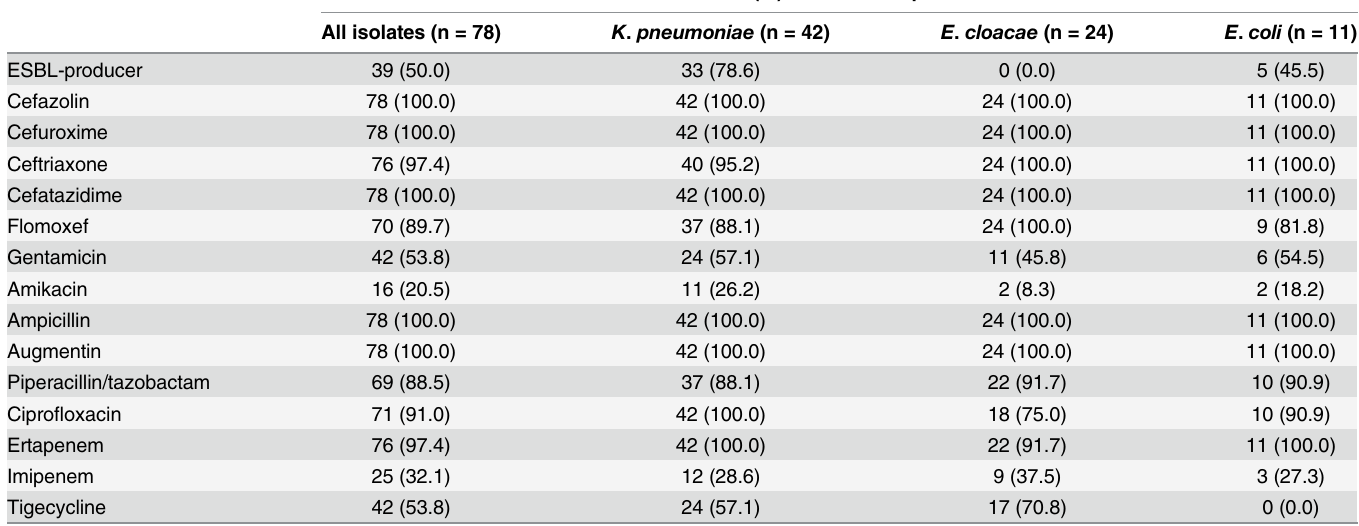
Table 2. Antibiotic non-susceptible